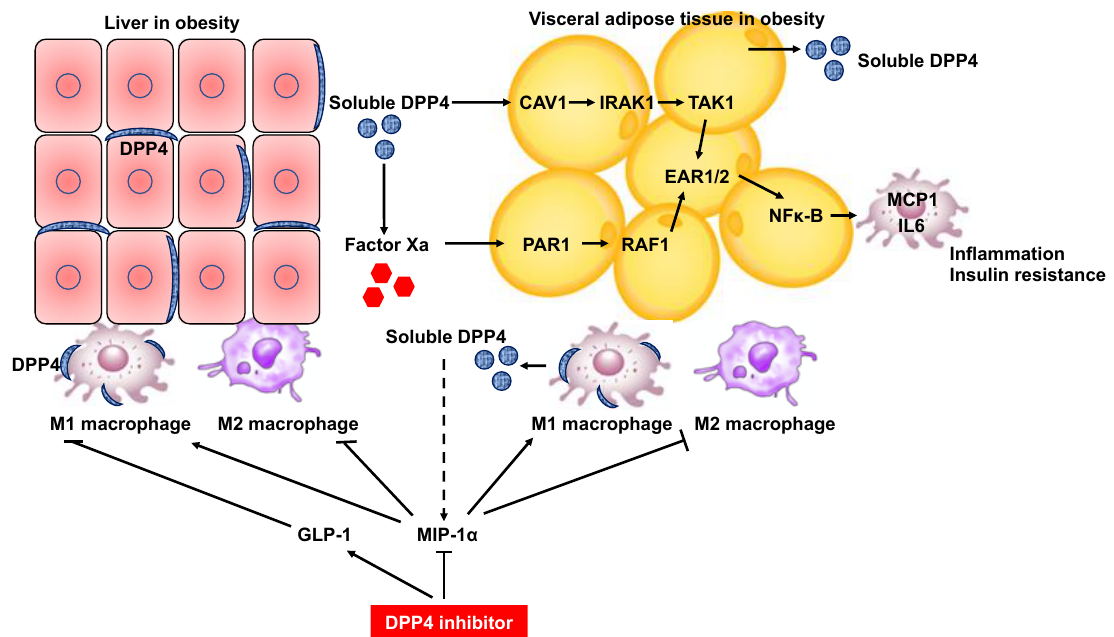
Figure 3. Schematic diagram depicting DPP4 inhibitor-mediated inhibition of inflammation in the liver and adipose tissues through amelioration of dysregulated M1/M2 polarization of macrophages. Hepatocyte DPP4 expression in the context of obesity results in secretion of soluble DPP4, which interacts with factor Xa. Soluble DPP4 and factor Xa activate two separate pathways (the CAV1-IRAK1-TAK1 pathway for DPP4 and the PAR2-RAF1 pathway for factor Xa), which synergistically stimulate ERK1/2 and NF- κ B to induce MCP1 and IL-6 expression in adipose tissue macrophages. Silencing of DPP4 expression in hepatocytes but not treatment with DPP4 inhibitors suppress inflammation of VAT. Soluble DPP4 is also released from adipose tissue as an adipokine in obese individuals. DPP4 is predominantly expressed in M1-polarized macrophages compared with adipocytes in white adipose tissue of diet-induced obese mice. DPP4 inhibitor treatment induces a reciprocal decrease in M1 macrophages and an increase in M2 macrophages in white adipose tissue and liver tissue of diet-induced obese mice. MIP-1 α becomes the most efficient monocyte chemoattractant after cleavage by DPP4 and is potentially a substrate of DPP4 for the regulation of macrophage polarization in the obese state. DPP4 inhibitor treatment also suppresses the upregulation of proinflammatory and fibrogenic genes in hepatic macrophages through enhancement of the circulating GLP-1 level in genetically obese NASH mice. CAV1, caveolin-1; IRAK1, interleukin-1 receptor-associated kinase; TAK1, TGF- β activated kinase 1; PAR2, protease-activated receptor 2; ERK, extracellular signal-regulated kinase; NF- κ B, nuclear factor kappa-light-chain-enhancer of activated B cells; MCP1, monocyte chemokine protein 1; GLP-1, glucagon-like